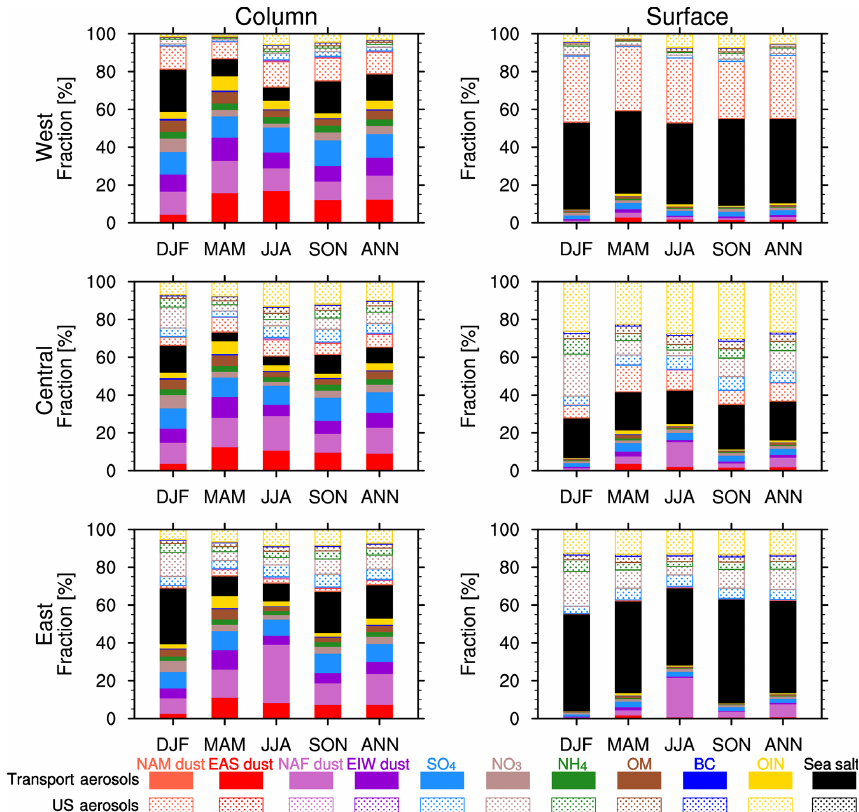
Figure 13. Seasonal and annual variation of trans-Pacific transport and US total aerosol mass fractional contribution for the column and at the surface from the WRF-Chem simulations averaged for 2010–2014 in the western, central, and eastern North America shown in Fig.